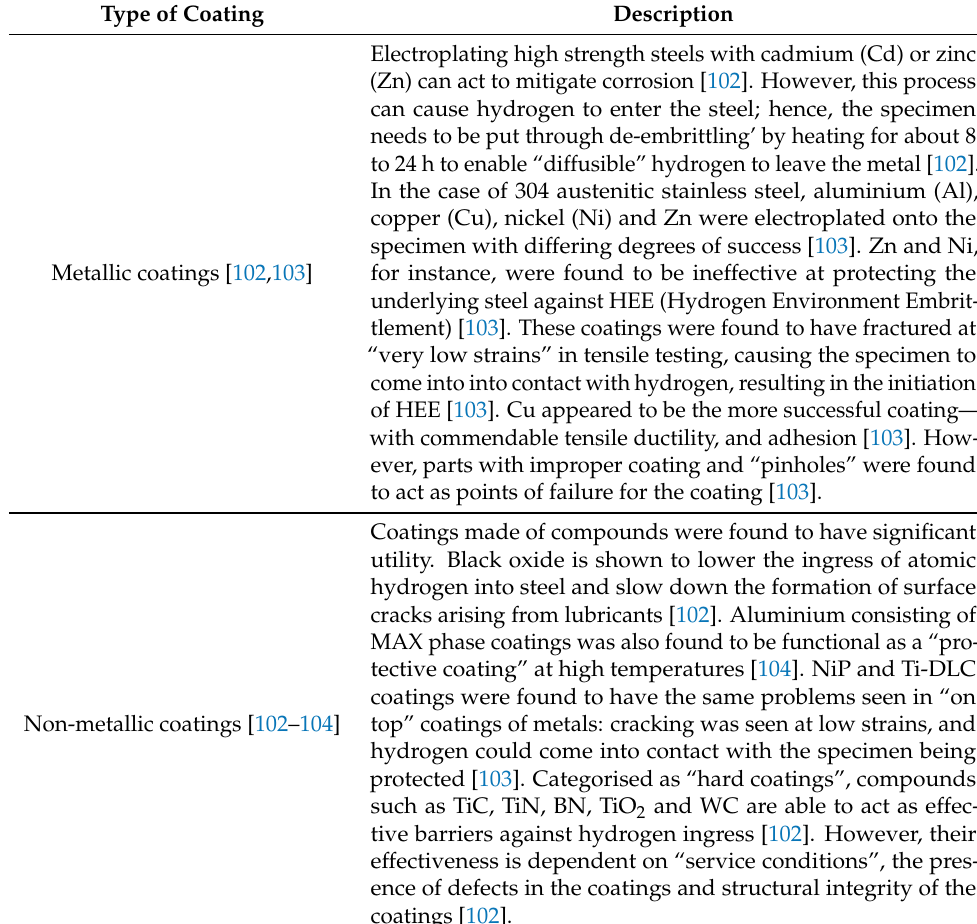
Table 9. Categorisation of coatings and their